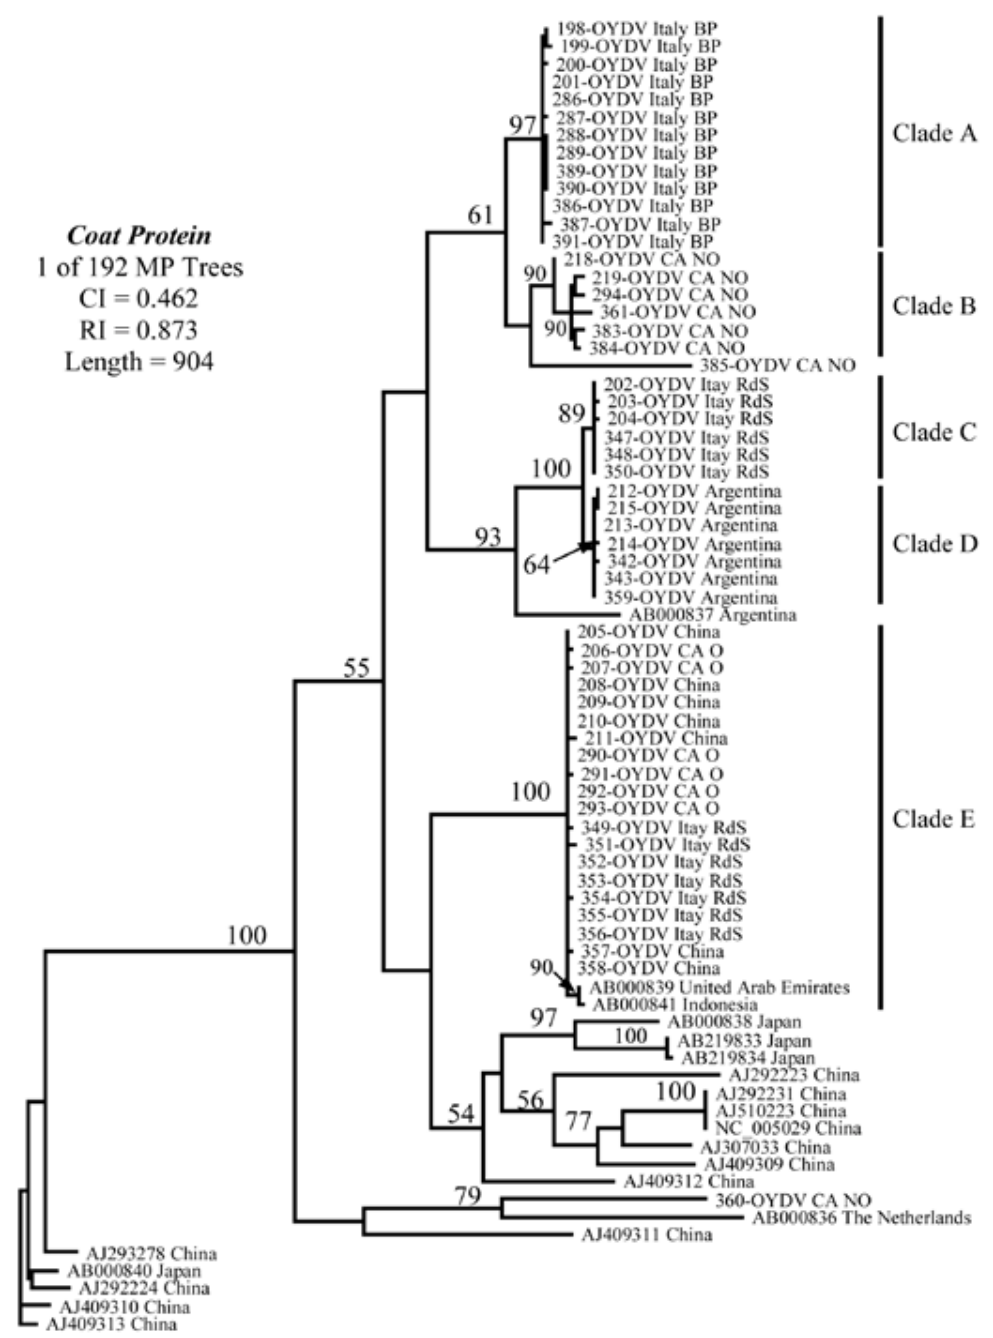
Figure 2. Maximum parsimony analyses of the coat protein gene for Onion yellow dwarf virus (OYDV) isolates obtained in this study, as well as sequences from GenBank. Bootstrap support of 50% and above is indicated above nodes based on 1,000 replicates. 198-391: Serial numbering of OYDV cDNA clones, BP: ‘Bianco Piacentino’, RdS: ‘Rosso di